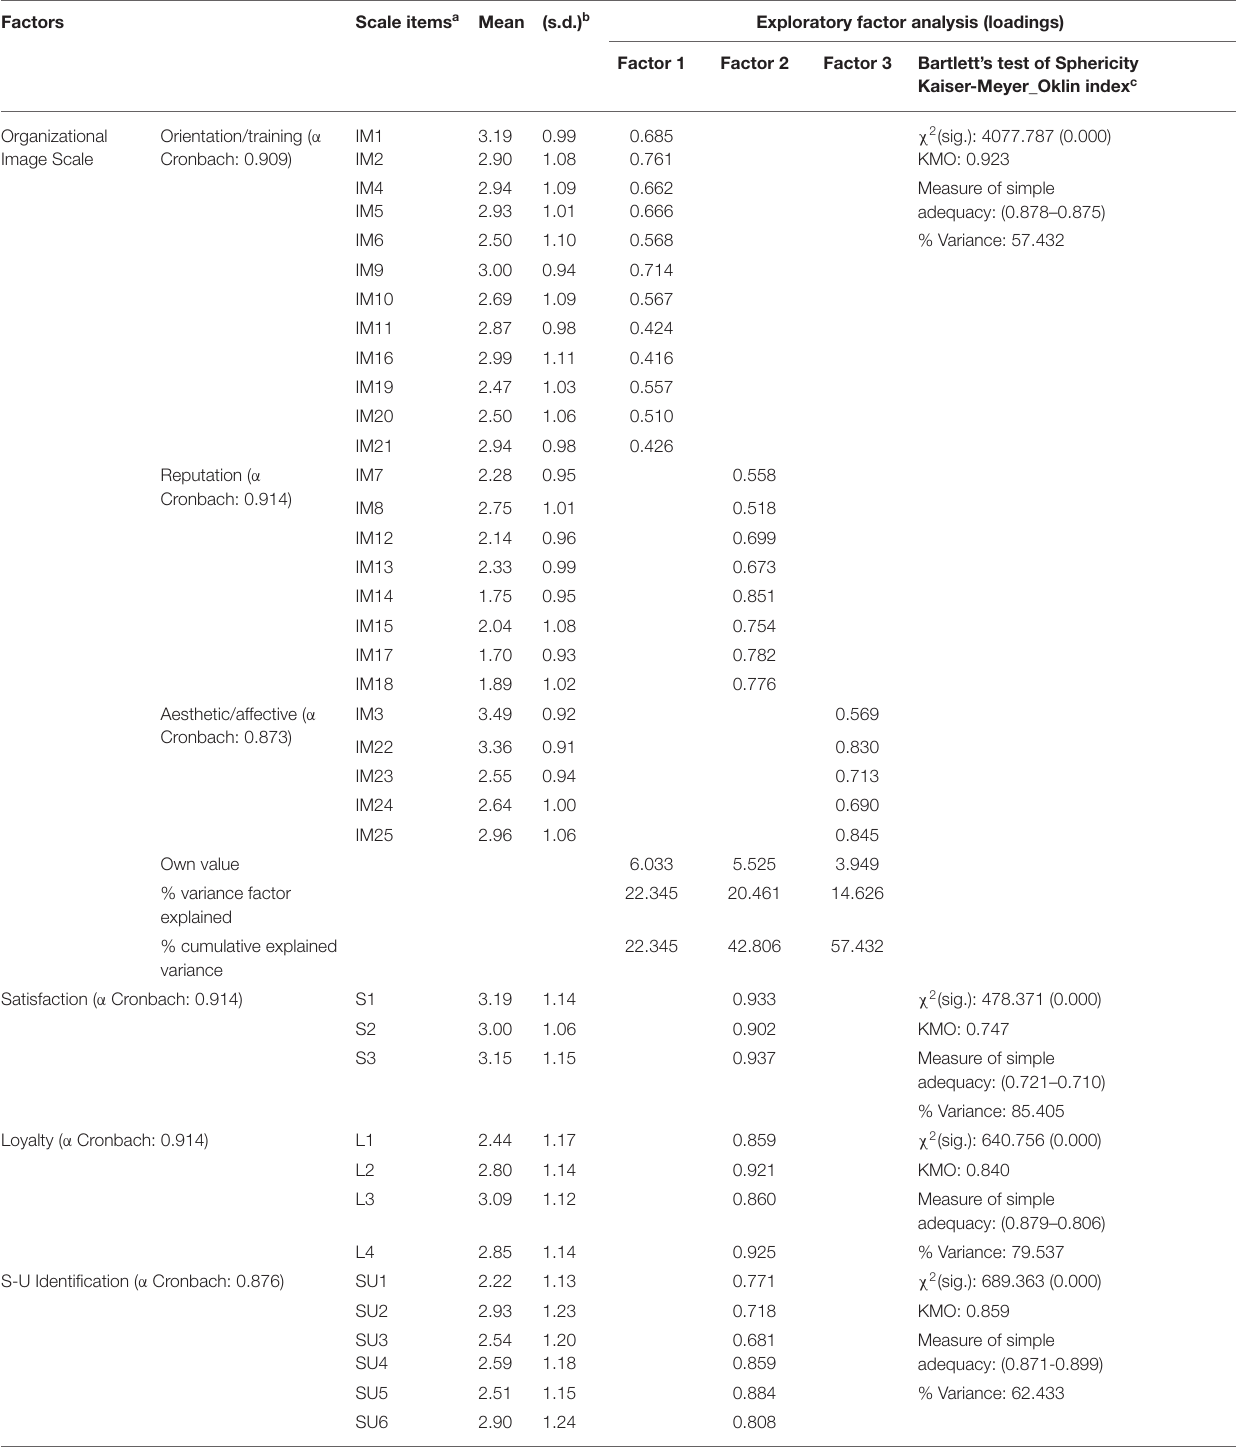
TABLE 1 | Descriptive findings and exploratory factor analysis (reliability and validity of scales).